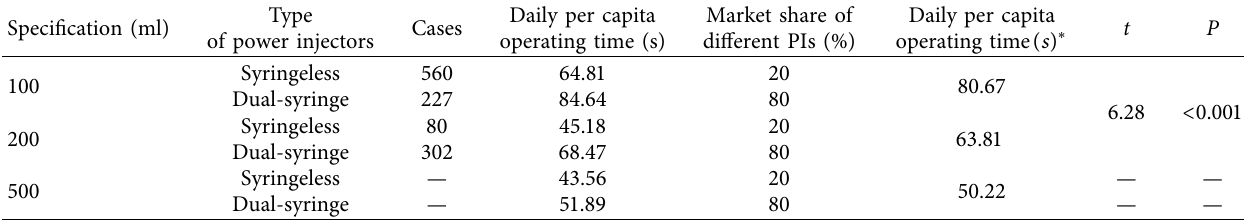
Table 3: Te daily per capita operating time of patients using diferent specifcations of contrast agents. Specifcation (ml)